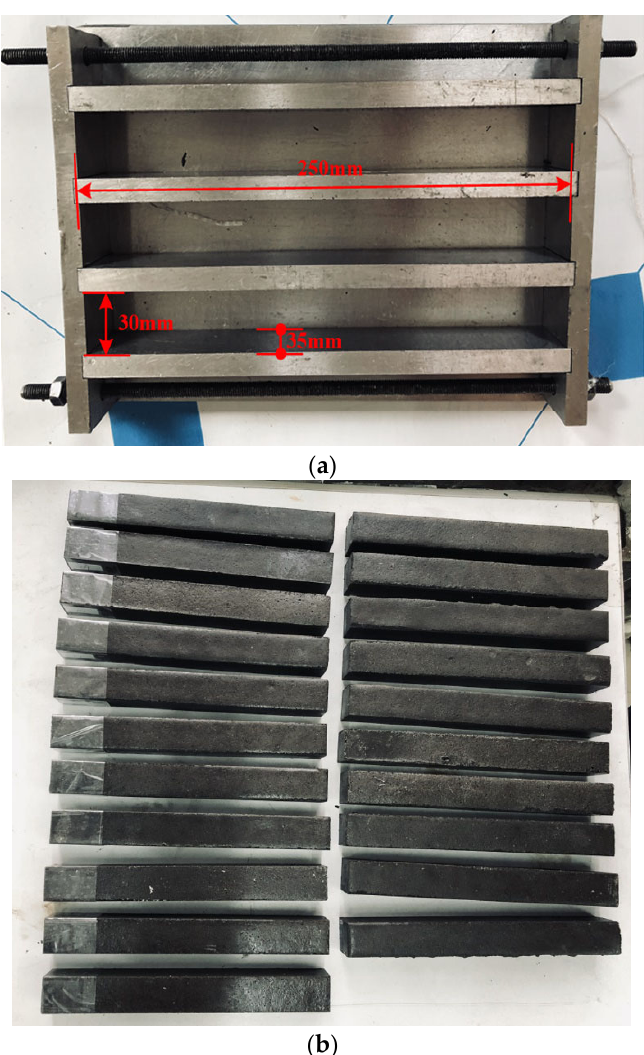
Figure 17. Preparation of polyurethane cement bending specimens: ( a ) add polyol; ( b ) add isocyanate; ( c ) add cement; ( d ) stirring; ( e ) pouring.